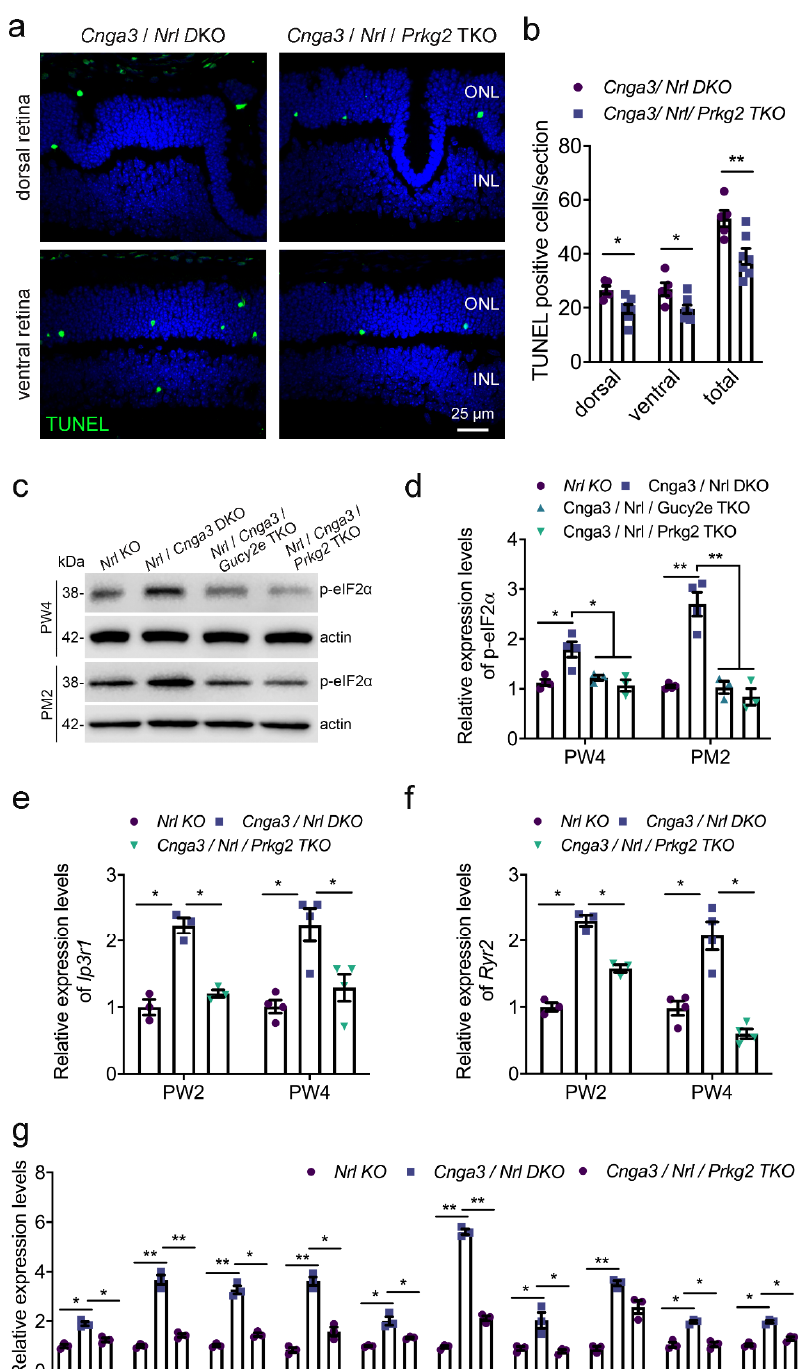
Figure 5. Dependence of Cnga3-linked ER stress and unfolded protein response (UPR) on Prkg2. ( a , b ) TUNEL-based evaluation of cell death on retinal cross sections of Nrl KO, Cnga3 / Nrl DKO, and Cnga3 / Nrl / Prkg2 TKO mice at week 2. Shown are representative confocal images of TUNEL labeling ( a ) and the corresponding quantifications ( b , n = 6–8). The scale bar in ( a ) applies to all shown images. ( c , d ) Western blot analysis of the ER stress marker p-eIF2a in retinal lysates from Nrl KO, Cnga3 / Nrl DKO, Cnga3 / Nrl / Gucy2e TKO, and Cnga3 / Nrl / Prkg2 TKO mice at postnatal month (PM) 1 and 2. Shown are representative immunoblotting images ( c ) and the corresponding quantifications ( d , n = 8 − 10). ( e – g ) mRNA expression levels of Itpr1 ( e ), Ryr2 ( f ) and indicated UPR-related genes in retinas of Nrl KO, Cnga3 / Nrl DKO, and Cnga3 / Nrl / Prkg2 TKO mice at week 2 and 4 ( e , f , n = 8–10) or at week 2 ( g , n = 6–8). * p < 0.05, ** p < 0.01, 1-way-ANOVA. Error bars shown are SEM. INL, inner nuclear layer; ONL, outer nuclear layer; PM, postnatal month; PW, postnatal